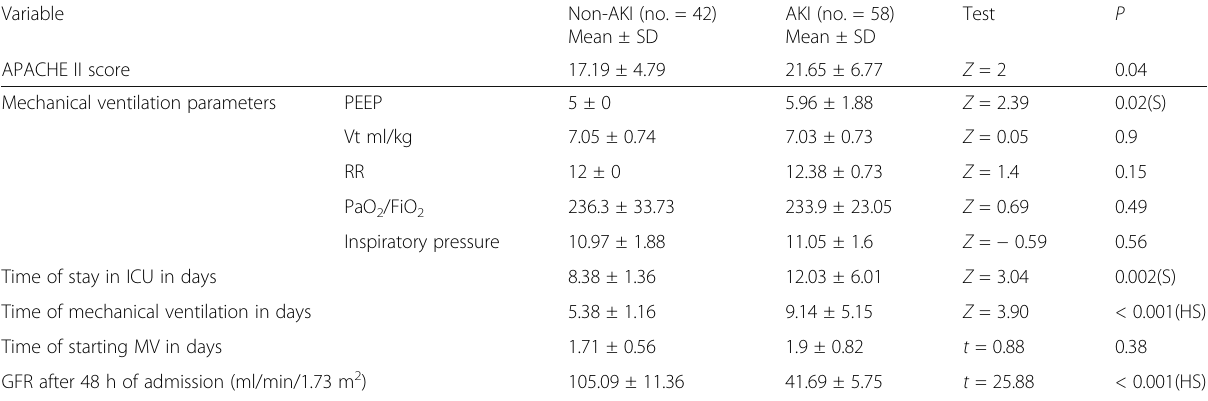
Table 5 Relation between kidney injury and APACHE II score, MV parameters, duration of ICU stay, and GFR among the studied groups